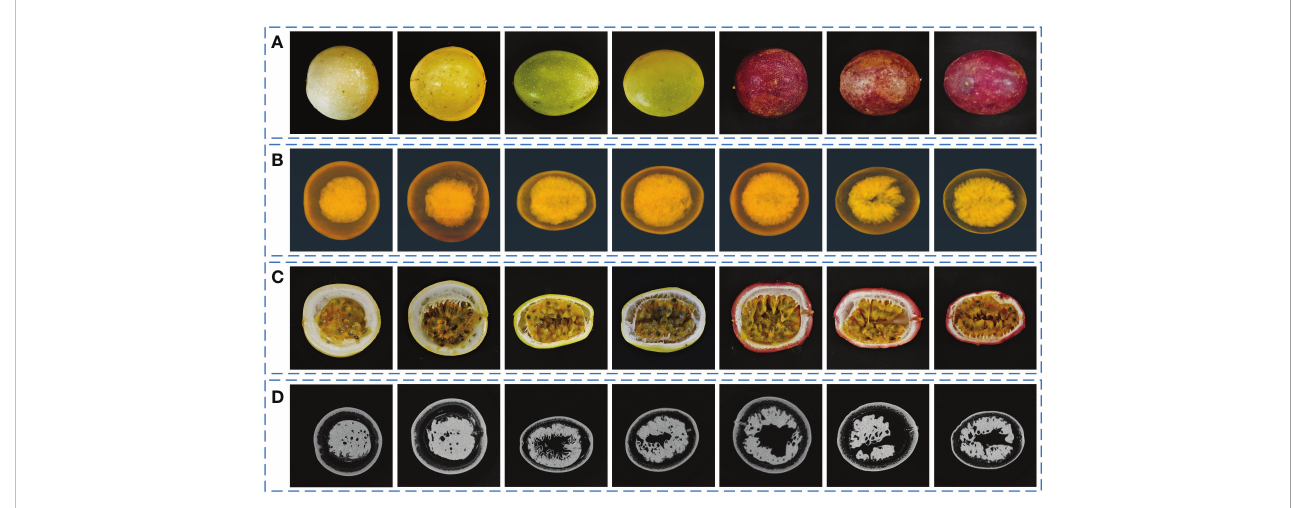
FIGURE 7 Seven morphologically representative passion fruit samples. (A) RGB images of samples. (B) 3D-reconstruction images of samples from Micro-CT. (C) RGB cross-sectional view of samples. (D) Tomogram images of samples from